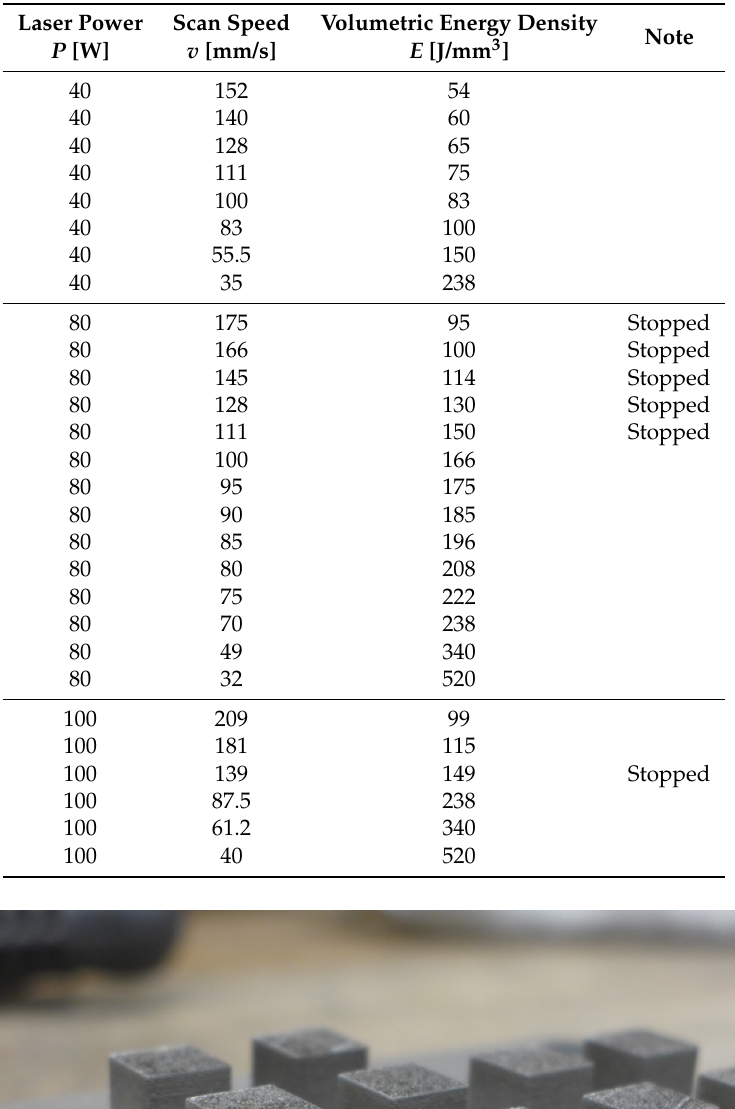
Table 2. Process parameters for AW701 powder mixture.